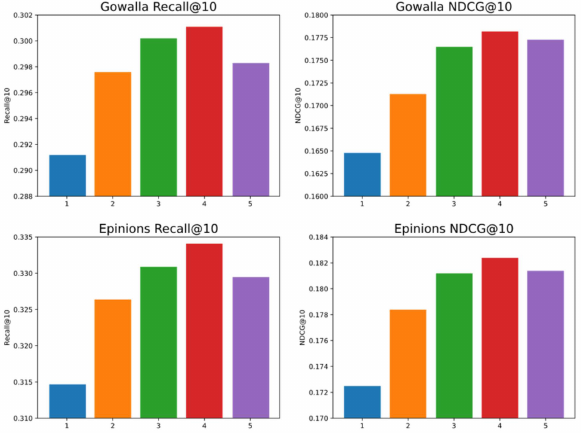
Figure 7. Effect of #layers l on Gowalla and